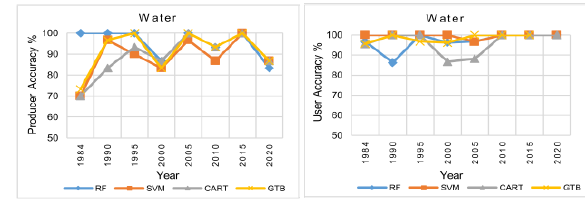
Figure 9 : PA and UA results for water body mapping.